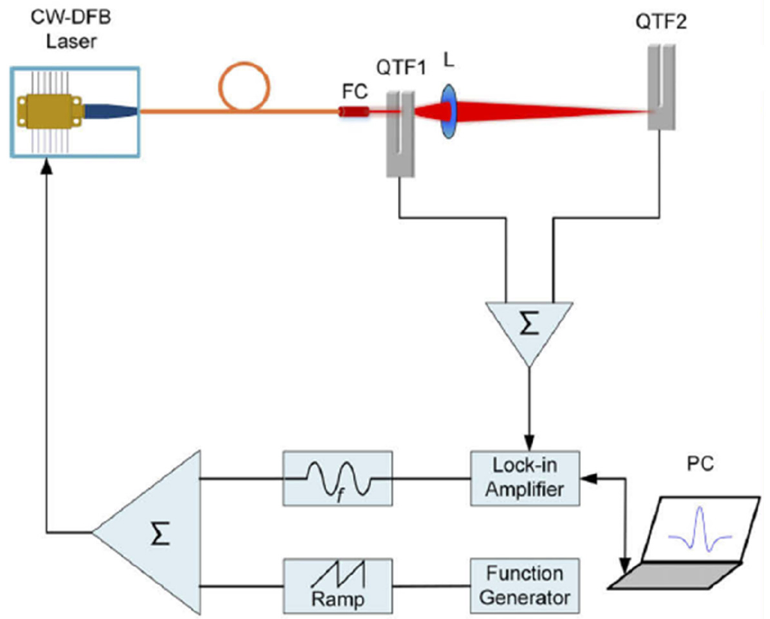
Figure 4. Experimental setup of the QEPAS-LITES sensor system. Σ : adder. Reprinted/adapted with permission from Ref. [102]. Copyright 2021, copyright The Optical Society.